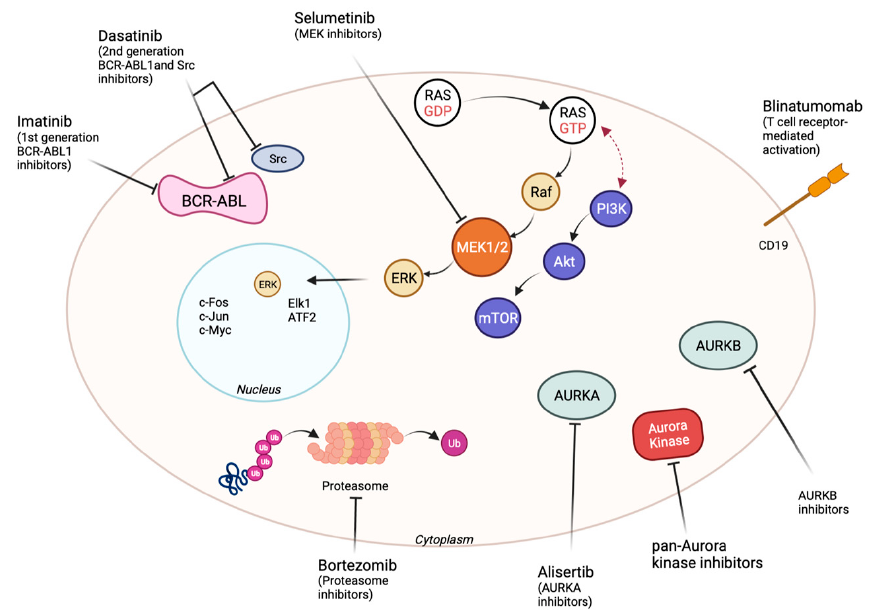
Figure 1. Overview of targetable pathways in pediatric B-ALL.